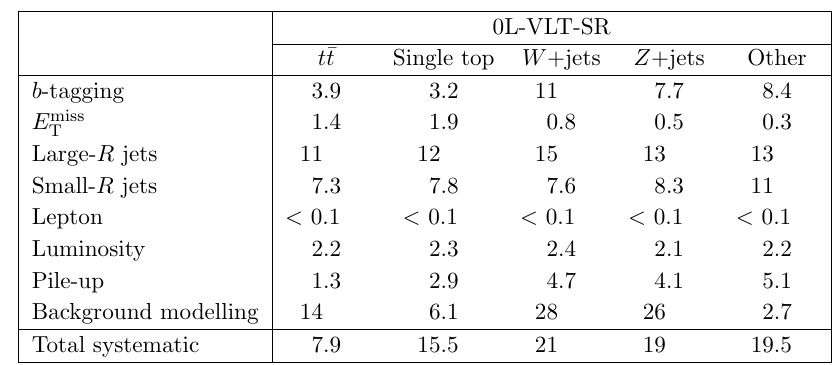
Table 2 . Relative e(cid:11)ect (in %) of various sources of systematic uncertainty on the predicted background yields in the signal regions used for the dark-matter search, obtained after the (cid:12)t to data. Individual sources of uncertainties are correlated, and their sum in quadrature is not necessarily equal to the total background uncertainty.